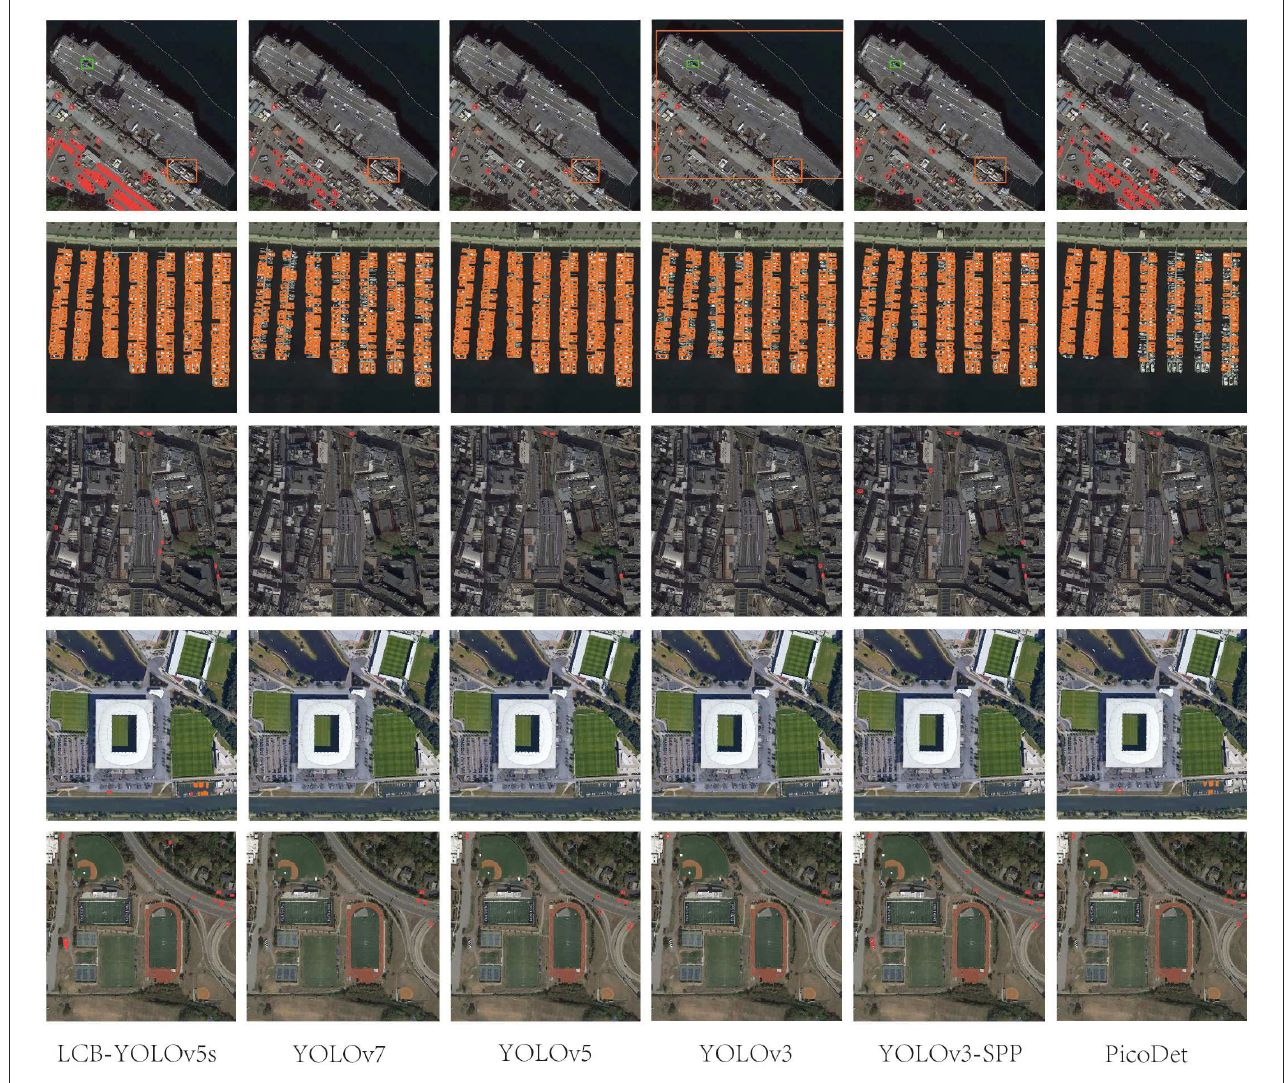
FIGURE13 Comparison of the target detection of six different models on the DIOR-VAS